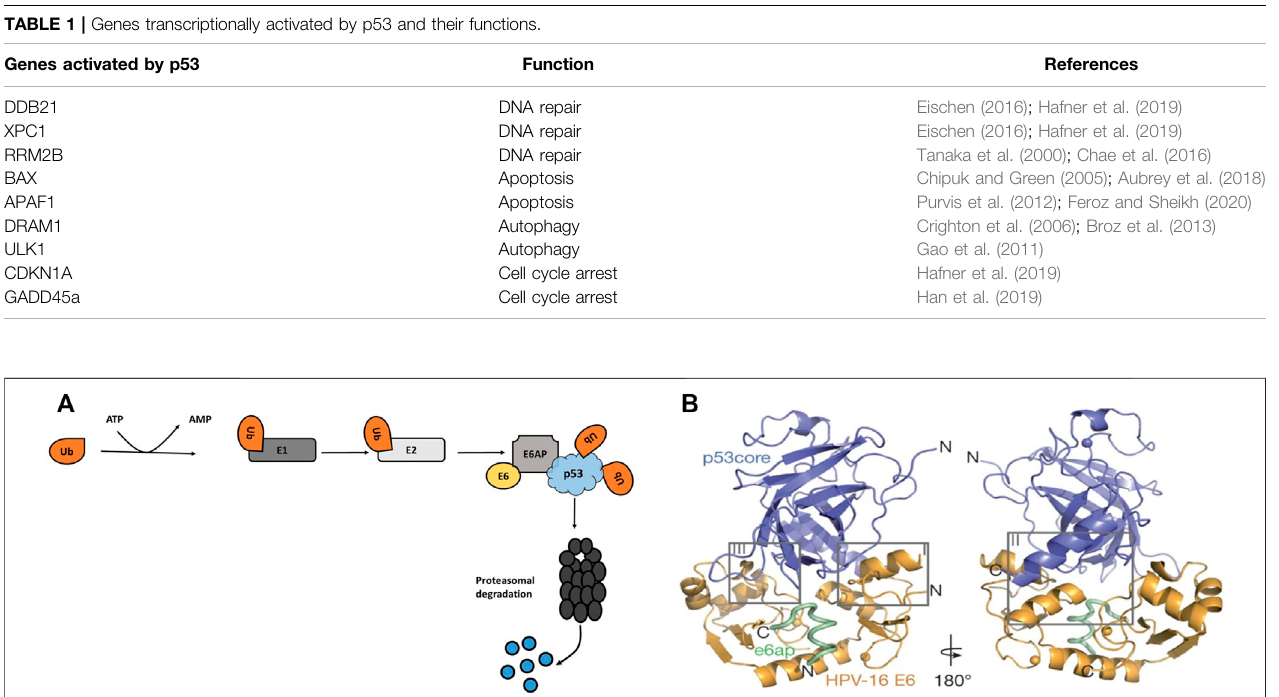
Frontiers in Molecular Biosciences |